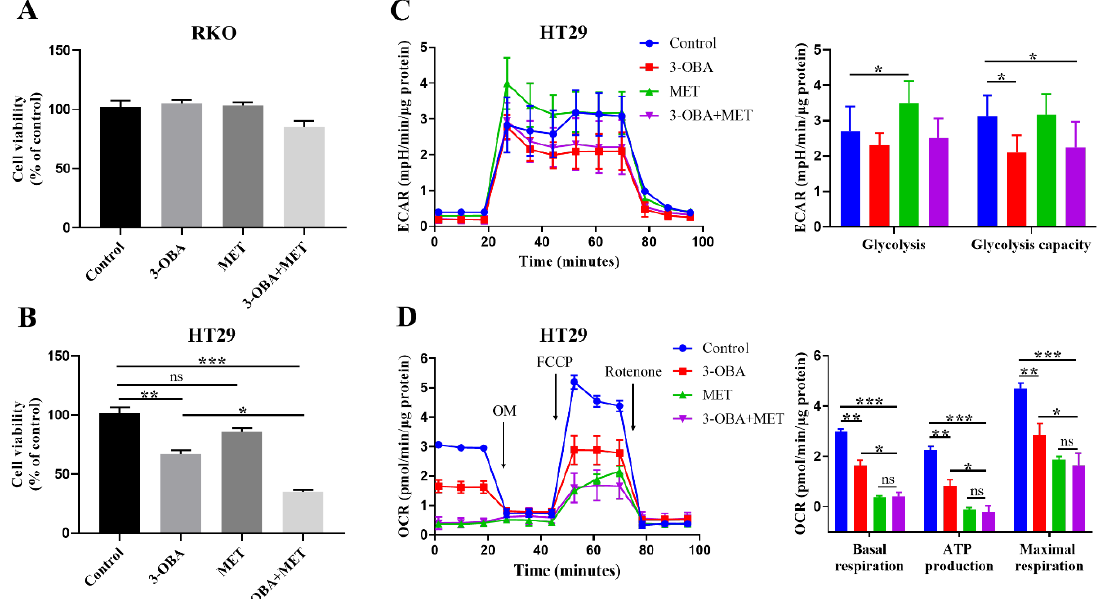
Figure 2. The combination of 3-OBA and metformin inhibits the cell proliferation and lactate metabolism of HT29. ( A , B ) RKO ( A ) or HT29 ( B ) cells were treated with 15 mM 3-OBA, 5 mM metformin, and the combination, then cell viability was determined by CCK-8 assay. ( C , D ) Extracellular acidification rate (ECAR) ( C ) or oxygen consumption rate (OCR) ( D ) of HT29 cells pretreated with 15 mM 3-OBA, 5 mM metformin, and the combination. The OCR were detected in the presence of oligomycin (OM), carbonyl cyanide-4 (trifluoromethoxy), phenylhydrazone (FCCP), and rotenone. Representative histograms of at least three independent experiments were shown. * p < 0.05, ** p < 0.01, *** p < 0.001; ns represents no significant difference.